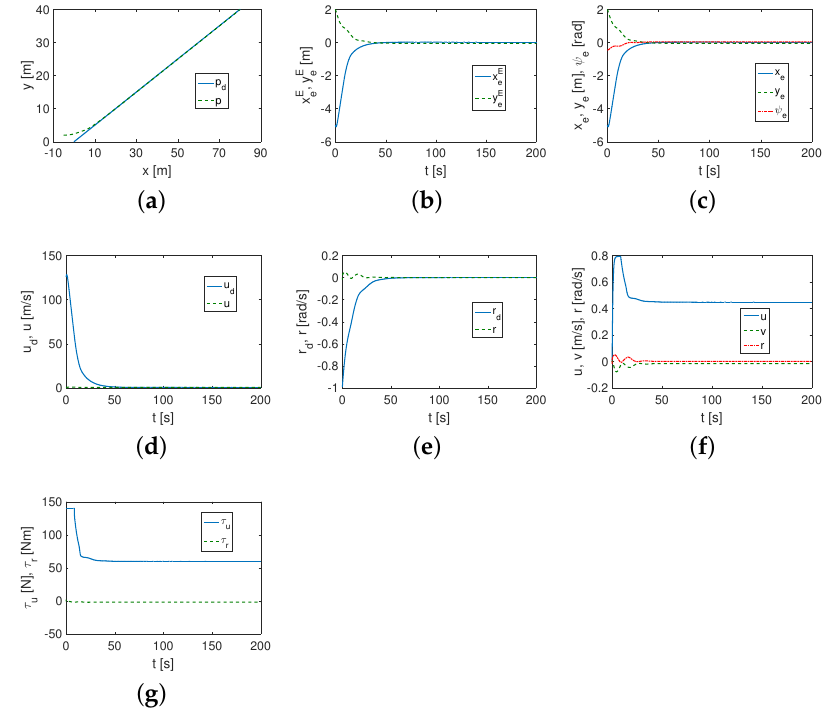
Figure 6. Simulation results for Kambara—IQV controller and linear trajectory (constant distur- bances): ( a ) desired and realized trajectory; ( b ) position errors (E-frame); ( c ) position errors (B-frame) and angular error; ( d ) desired and realized velocity ( u d , u ); ( e ) desired and realized velocity ( r d , r ); ( f ) realized velocities; ( g ) applied force and